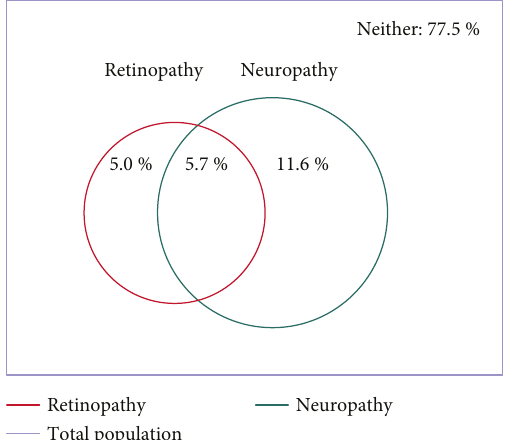
Figure 1: Prevalence of retinopathy and/or